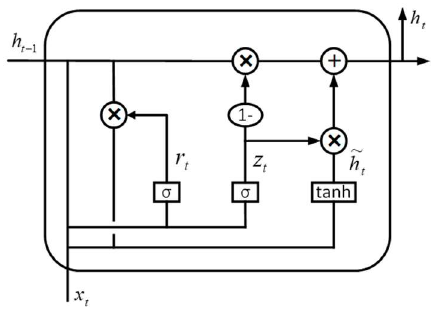
Figure 2. Structure of GRU model.